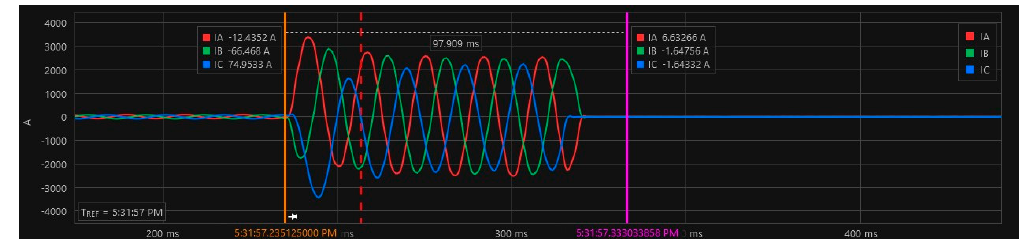
Figure 34. Phase voltages recorded by R1 under definite-time scheme. Figure 35. Trip logic and trip signal recorded by R1 under definite-time scheme. Figure 36. Event obtained for phase currents recorded by R2 under IDMT scheme. Under IDMT scheme, the relay operates as per the operating time set for it while relay configuration. The relay is supposed to trip after the specified fault duration. The afore- said functioning can be observed in Figure 37. The similar functioning can also be ob- served in Figure 28 where R2 operates the clear the fault using IDMT scheme. This vali- dates the waveforms obtained for R2 under IDMT scheme. Figure 37. Trip signal generated by R2 under IDMT scheme.